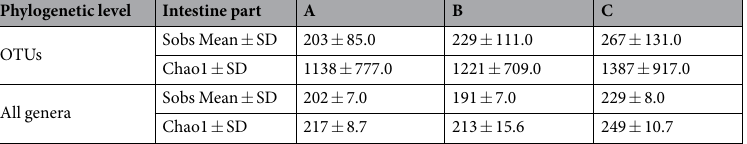
Table 1. Microbial richness of the three intestine parts in all cormorants (subsampled OTUs at the genera levels). The indexes Sobs Mean and Chao1 were calculated on the EstimateS (Version 9.1.0) software. Sobs Mean was calculated as the average number of all taxonomic units in all samples and Chao1 was calculated as the expected taxonomic richness for the complete collection of each intestine part (more details can be found in the Methods section). A - esophagus, B - middle, C - cloaca.